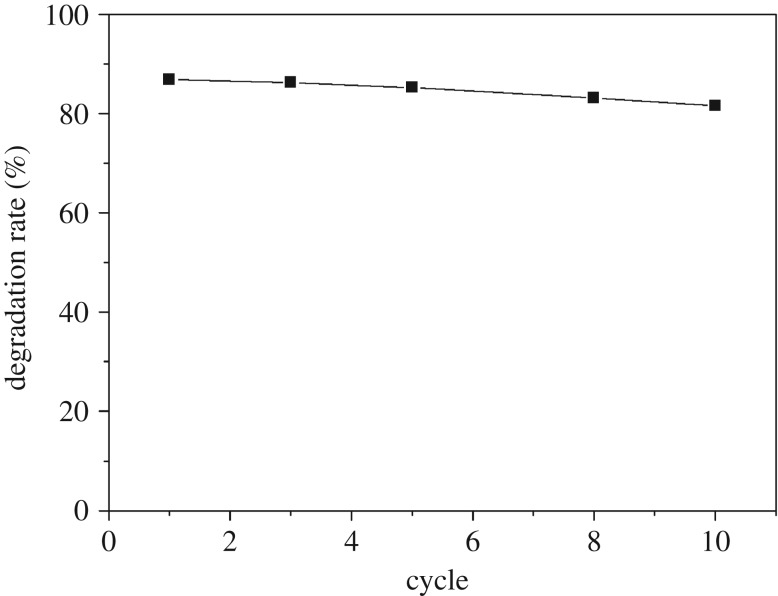
Stability of CoFe2O4–SiC foam.